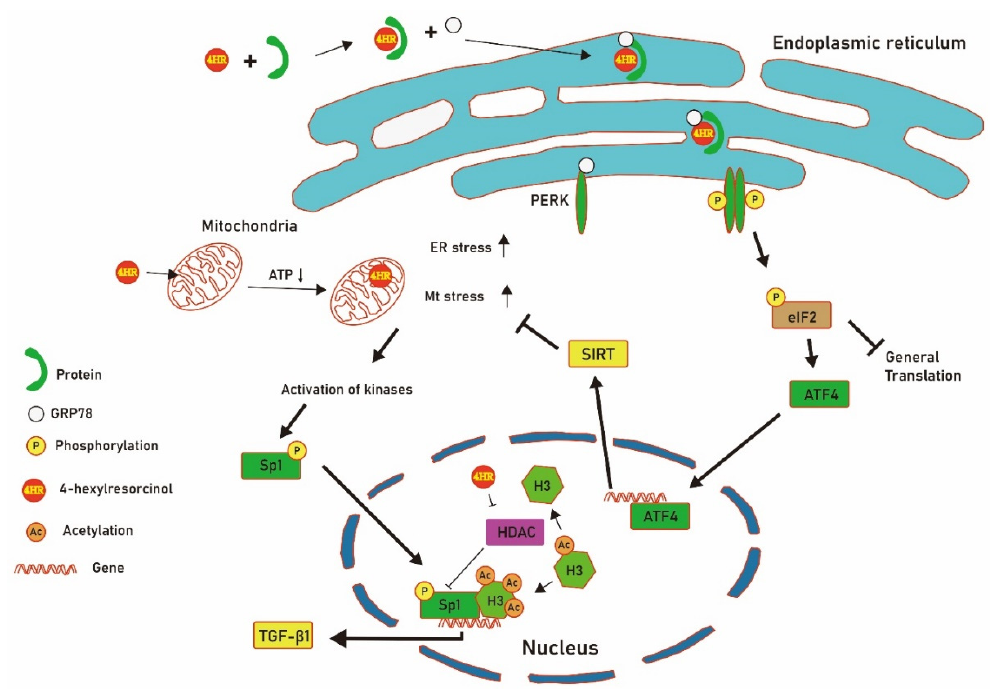
Figure 6. Schematic drawing of signaling pathway. 4HR administration induced both mitochondrial and ER stress. ER stress-induced ATF4 expression may increase SIRT, and SIRT may alleviate mitochondrial stress and kinase activation. Mitochondrial stress induced kinase activation and increased Sp1 phosphorylation. To activate TGF- β 1 transcription, not only p-Sp1 but also hyper-acetylated H3 is required. Since 4HR is a class I HDAC inhibitor and reduces the expression levels of HDAC4 and HDAC5 [22], H3 could be hyper-acetylated by 4HR administration.